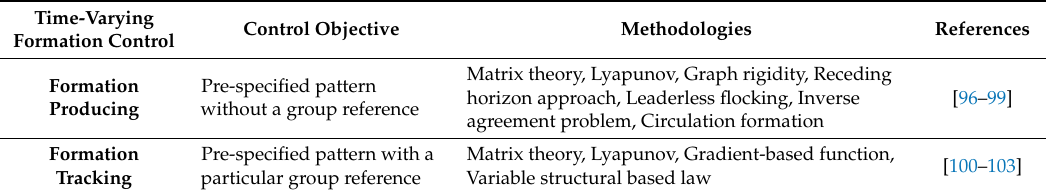
Table 5. Formation Control with respect to Time ‐ varying.